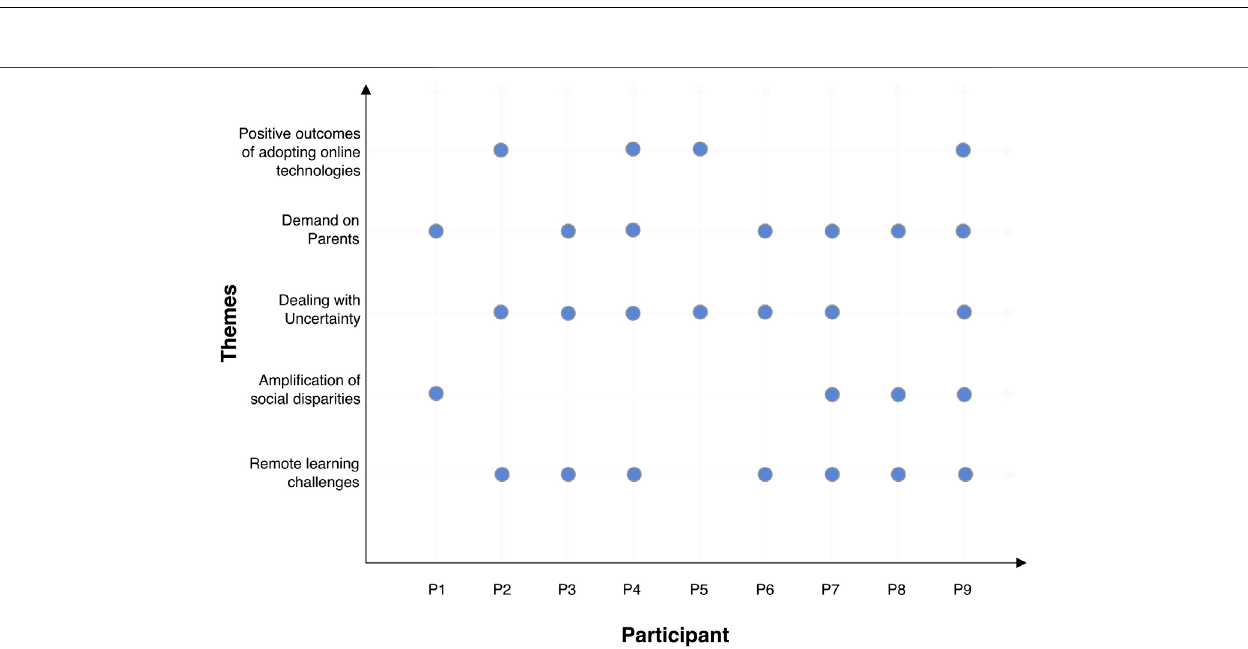
FIGURE 3 | A visualization of input from participants ’ data mapped to each